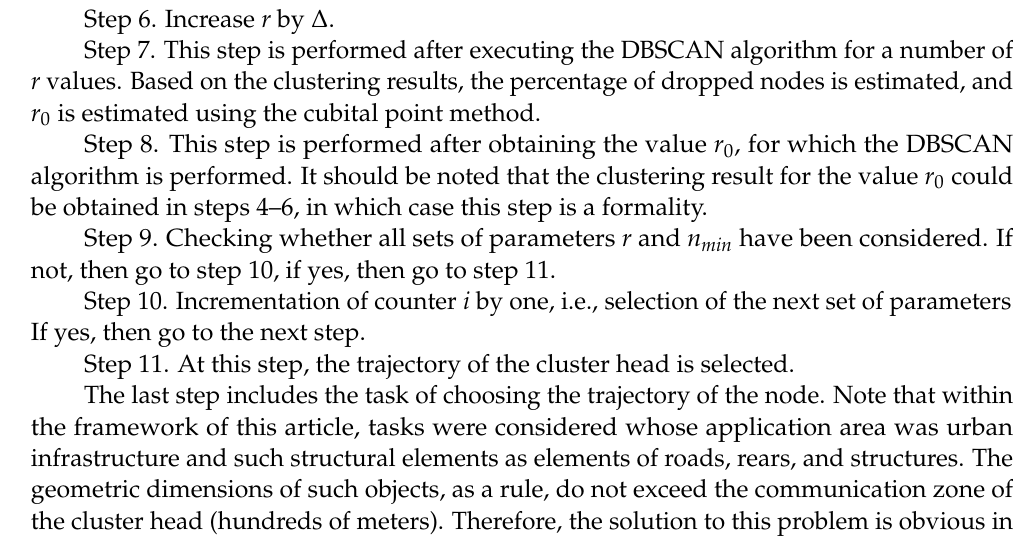
Figure 6. Algorithm of the method (process) for selecting the motion parameters of the mobile head units .